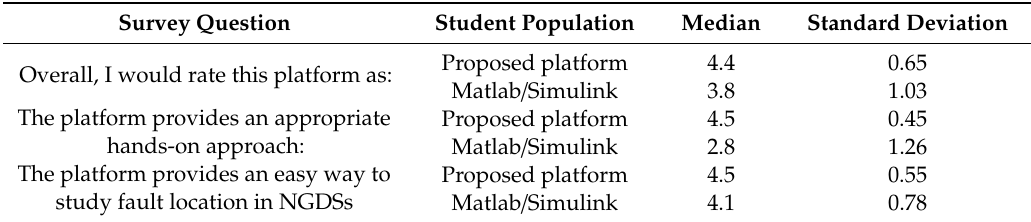
Table 7. Students’ evaluation of the proposed